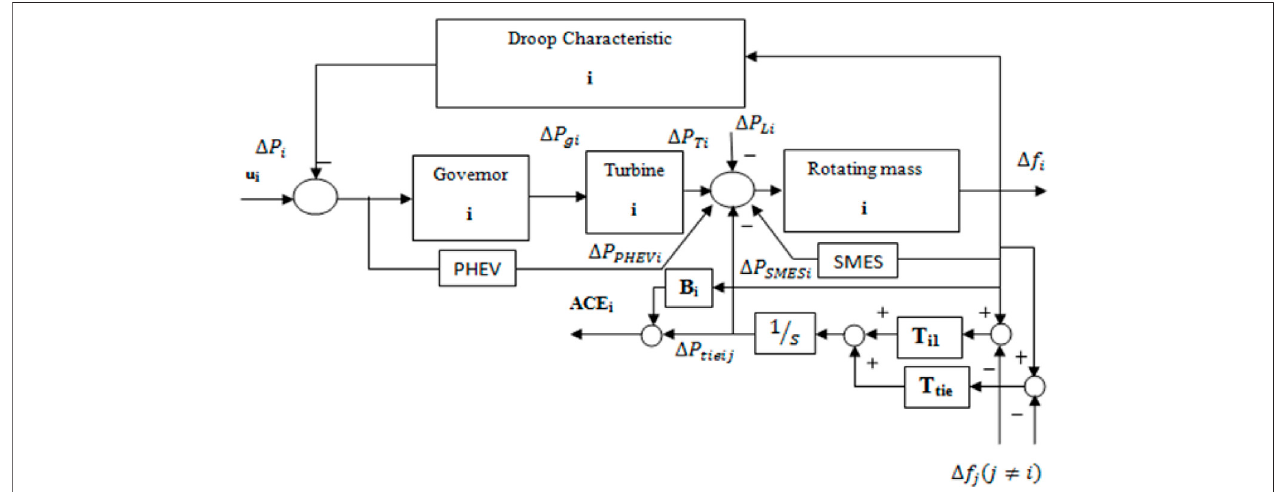
FIGURE 1 | LFC of the interconnected power system with PHEV and SMES